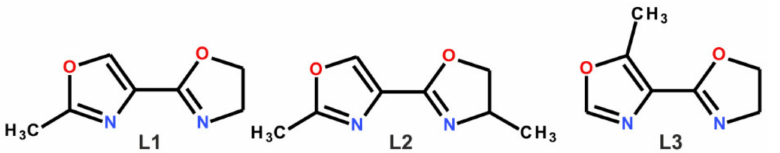
Figure 1. The structure of ligands: (L1) 4-(4,5-dihydro-1,3-oxazol-2-yl)-2-methyl-1,3-oxazole, (L2) 4-(4-methyl-4,5-dihydro-1,3-oxazol-2-yl)-2-methyl-1,3-oxazole, (L3) 4-(4,5-dihydro-1,3-oxazol-2-yl)-